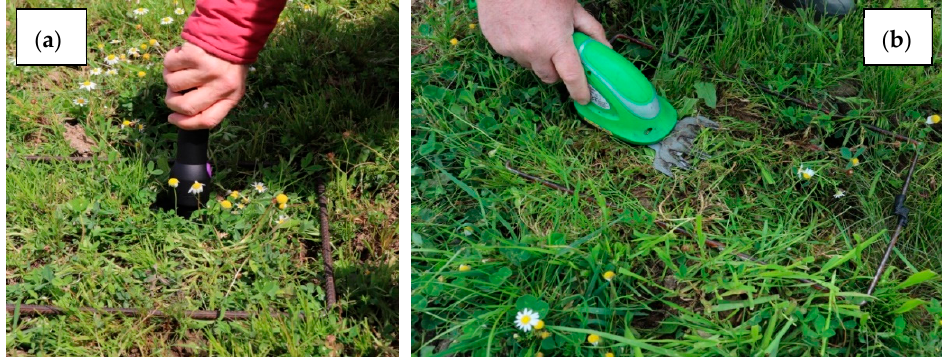
Figure 2. Portable near-infrared (NIR) sensor measurement ( a ) and pasture sample cut ( b ). Reference Chemical